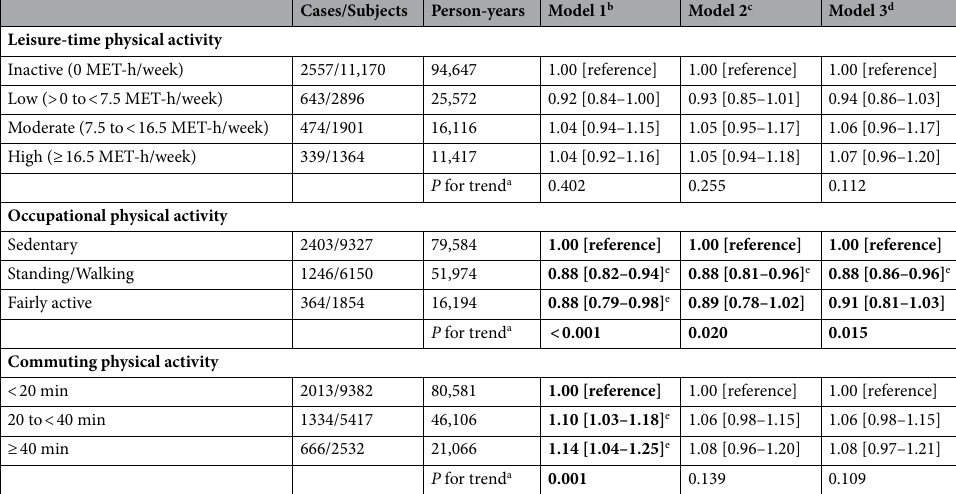
Table 2. Hazard ratios of chronic kidney disease, according to leisure-time, occupational, and commuting physical activity. Data are shown as the hazard ratio [95% confidence interval]. a P value for the linear trend was calculated by using the Cox proportional hazards regression and assigning each category of physical activity as a continuous variable. b Model 1 was adjusted for baseline estimated glomerular filtration rate (60 to 89 or ≥ 90 mL/min/1.73 m 2 ), age (continuous), and sex. c Model 2 was further adjusted for baseline smoking status (never, former, or current), alcohol consumption (0, > 0 to < 2, or ≥ 2go/day), occupation (engineering, production, office and administration, or others), job position (high or low), overtime work (< 45, 45 to < 60, 60 to < 80, 80 to < 100, or ≥ 100 h), shift work (yes or no), commuting mode (walking, bicycling, train/bus, or car/motorbike), sleep duration (< 5, 5 to < 6, 6 to < 7, or ≥ 7 h per day), and the other types of physical activity (i.e., leisure-time physical activity [0, > 0 to < 7.5, 7.5 to < 16.5, or ≥ 16.5 MET-h/week], occupational physical activity [sedentary, standing or walking, and fairly physically activity], or walking for commuting to and from work [< 20 min, 20 to < 40 min, or ≥ 40 min]). d Model 3 was further adjusted for potential mediators, including baseline hypertension, diabetes, history of cardiovascular disease, dyslipidemia, hyperuricemia, and body mass index (< 18.5, 18.5 to < 25.0, 25.0 to < 30.0, or ≥ 30.0 kg/m 2 ). e P < 0.05